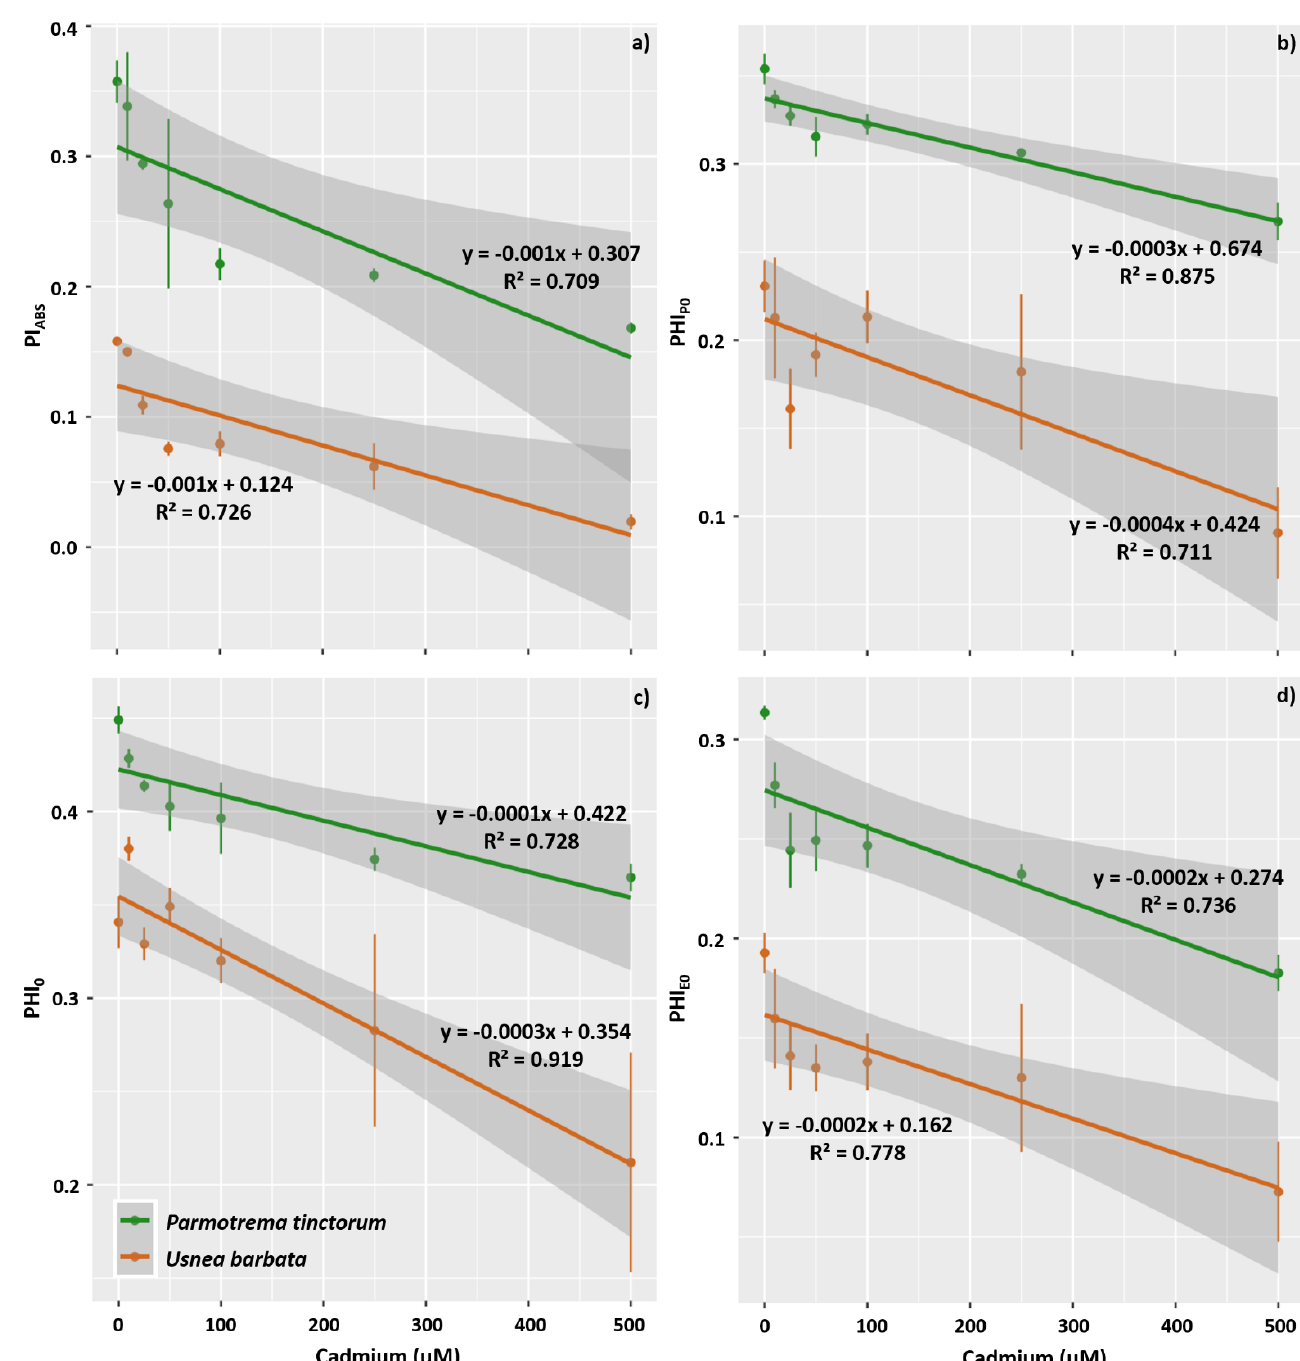
Figure 7. Chlorophyll a fluorescence parameters: PiAbs ( a ), PHIP0 ( b ), PHI0 ( c ), and PHIE0 ( d ) observed for the photobiont of the lichen species Parmotrema tinctorum and Usnea barbata subjected to different concentrations of Cd (0, 10, 25, 50, 100, 250, and 500 µM). The straight lines represent the fitted model, and the prediction intervals (95%) are gray.